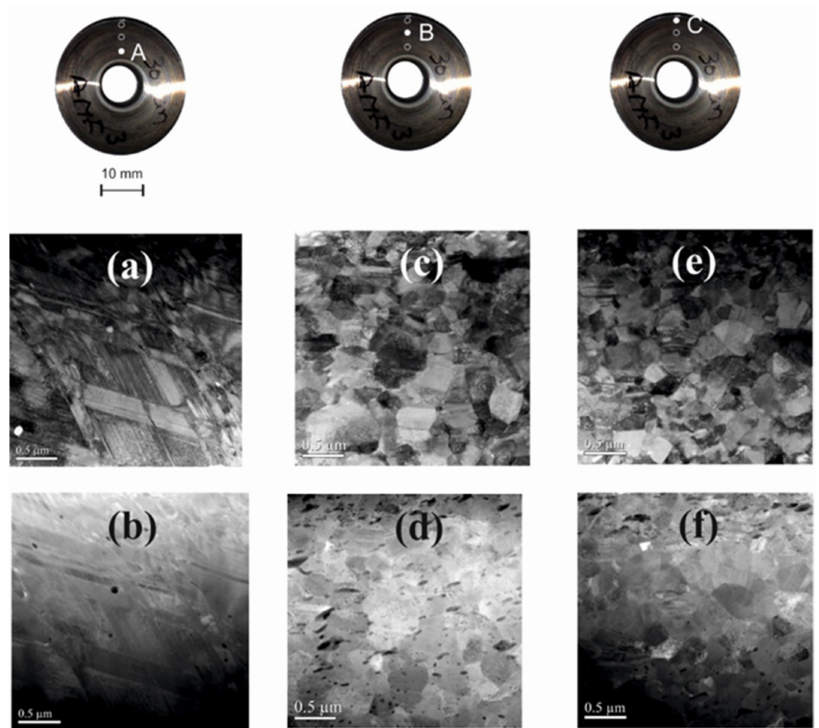
Figure 2. Truncated shells after HSHTP in three different radial areas, and the corresponding TEM and ADF micrographs grouped as follows: area ( A ) ( a , b ), area ( B ) ( c , d ) and area ( C ) ( e , f